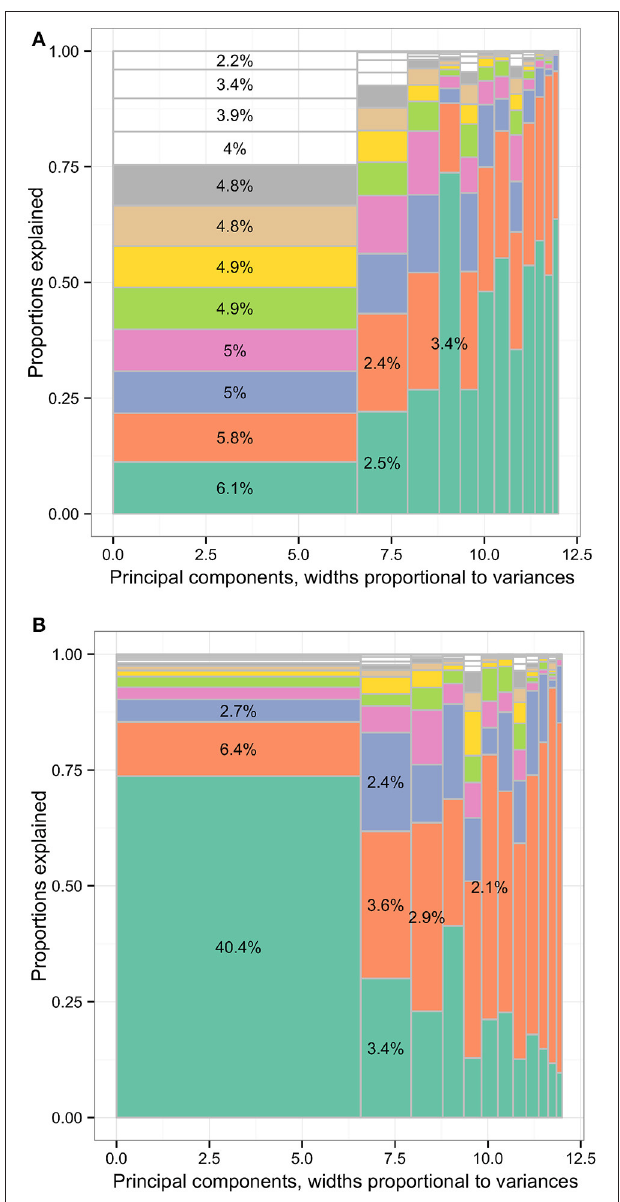
FIGURE 8 | The distribution of total variances by principal components and input variables or approximation variables in the MEPS SF-12v2 dataset. Principal components, widths proportional to variances. (A) The distribution of total variances by principal components and input variables. Principal components, widths proportional to variances. (B) The distribution of total variances by principal components and approximation variables. MEPS, Medical Expenditure Panel Survey; SF-12v2, the Short-Form 12 Version 2. The percentages in the cells representing the percentages of variances relative to total variance (whole area) based on the loadings of principal component analysis (first charts) or R squared. Each column represented the principal components (PCs) and had widths the same as the PC variance. In each column, the cells were of unequal sizes representing the variances explained by the input variables. For each PC specified in each column, the PC was explained by input variables. The cells in each column represented the input